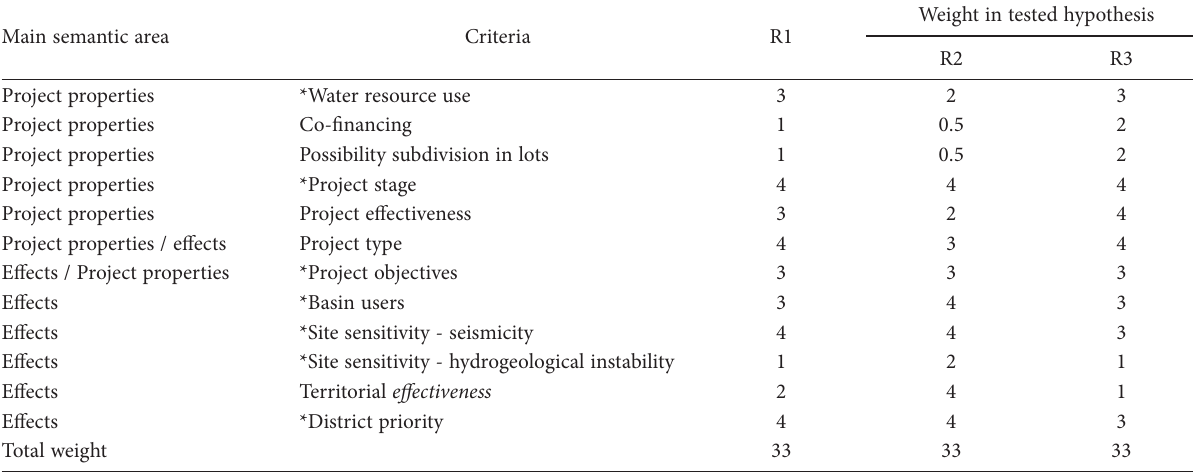
Table 5. Weights of the criteria according to the two tests (*criteria mostly linked to the definitions given in the reference law), compared to those assigned by the Technical